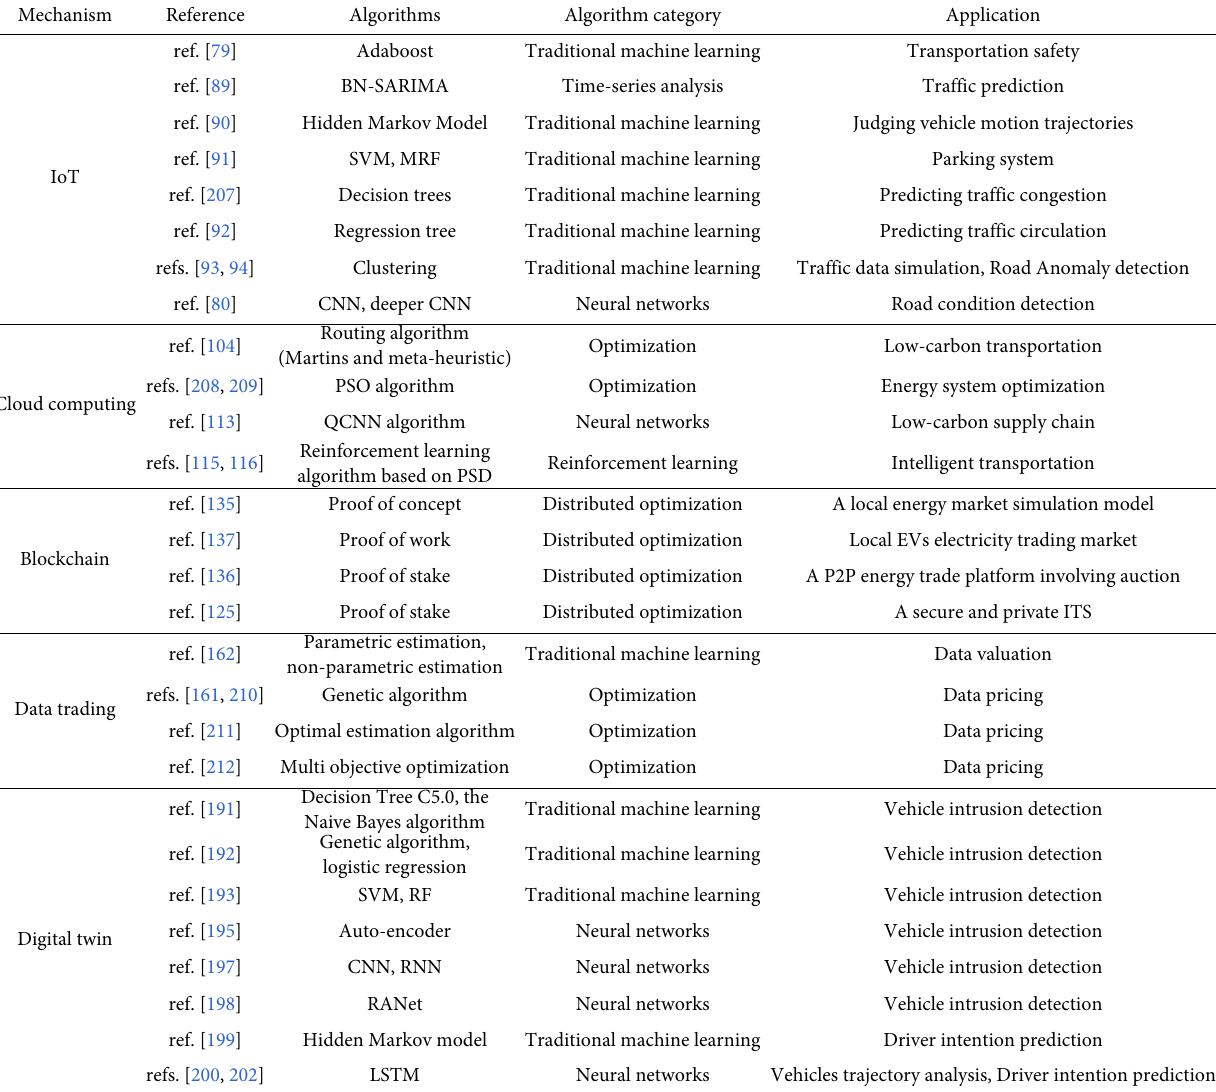
Table 1 Algorithms. Mechanism